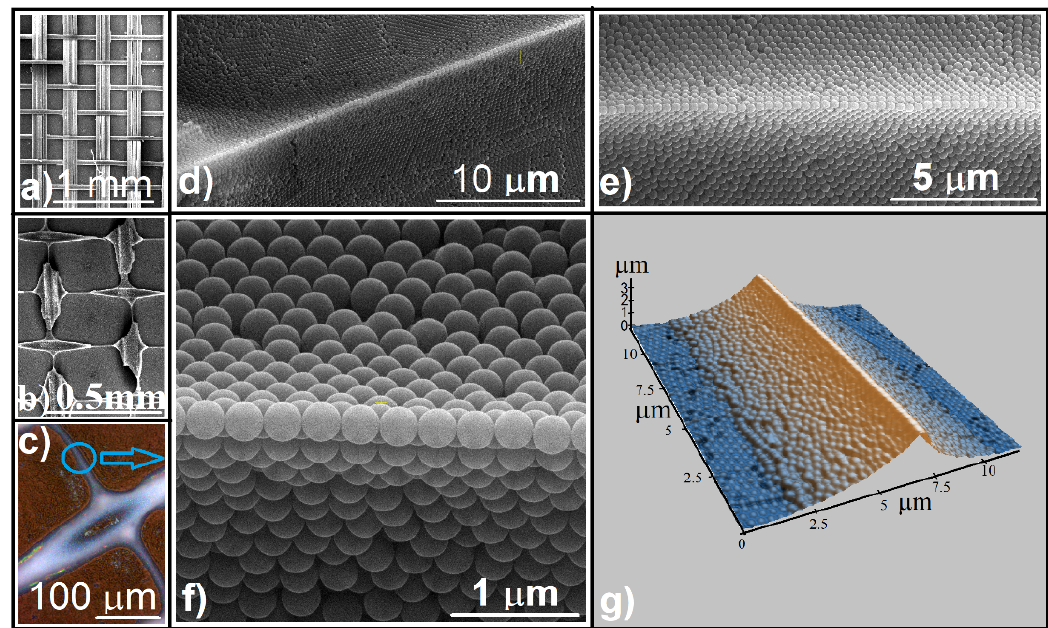
Figure 2. Patterned and shaped colloidal crystal: ( a ) SEM image of the fabric structure; ( b ) SEM image of the patterned crystal; ( c ) optical microscopy image of a cells-unit intersection; ( d – f ) SEM images of triangular prisms of colloidal crystals; ( g ) AFM image of a triangular prism.